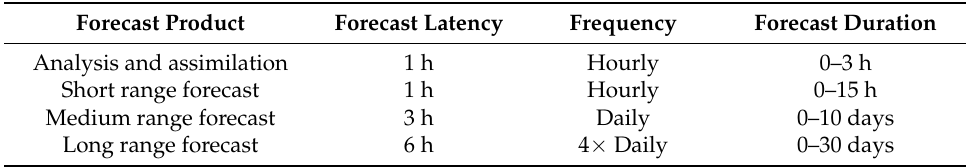
Table 1. National Water Model details